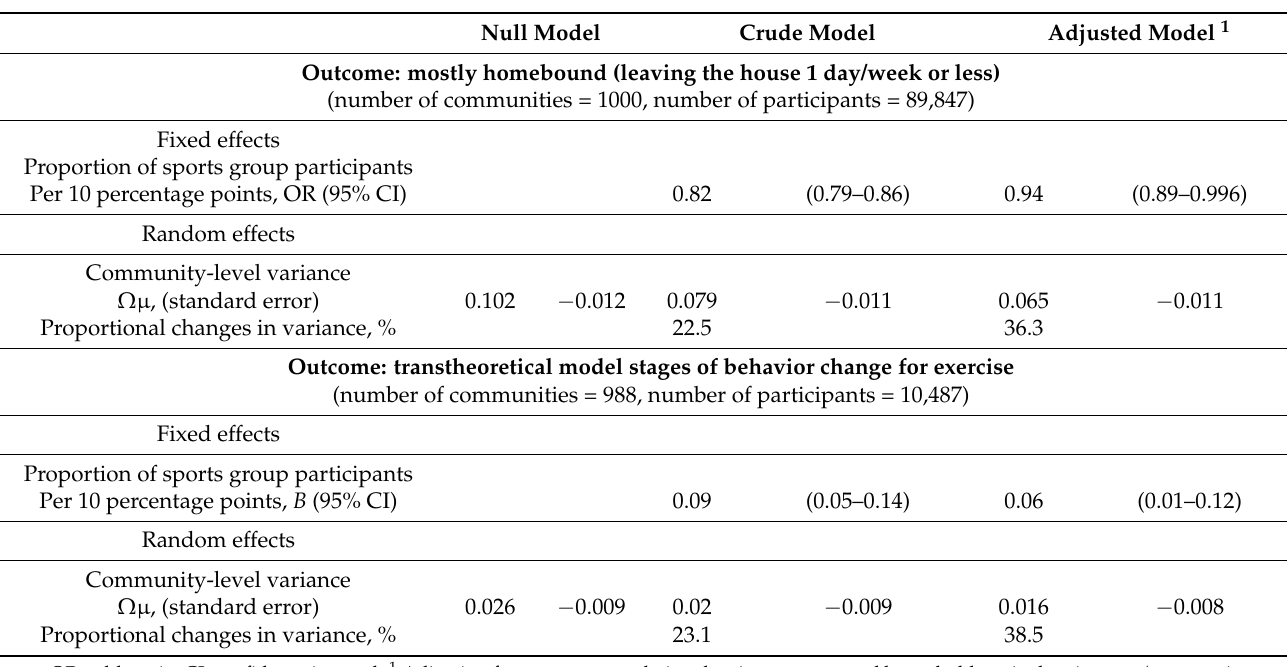
Table 3. Point estimates and 95% confidence intervals (CIs) estimated from multilevel regression analyses in each